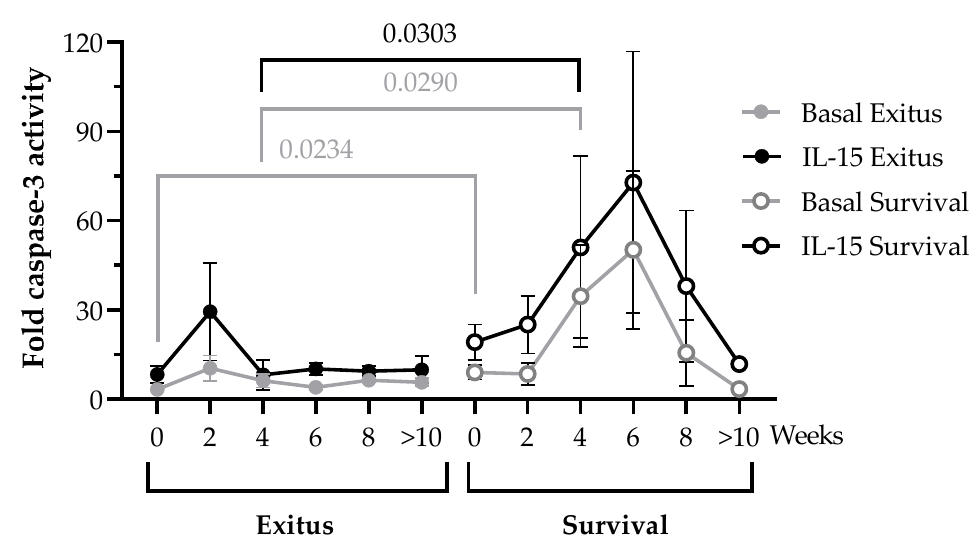
Figure 3. Direct cellular cytotoxicity of PBMCs isolated from hospitalized patients with critical COVID-19. Cytotoxic capacity of PBMCs from individuals of the Exitus (filled dots) and Survival (blank dots) groups measured by quantifying caspase-3 activity in a monolayer of Vero E6 cells infected with pseudotyped SARS-CoV-2 after co-culture (1:1) for 1 h in basal conditions (gray lines) or after treatment with IL-15 for 48 h (black lines). Each dot corresponds to the mean of data, and vertical lines represent SEM. Statistical significance between groups was calculated using Mann–Whitney U-test, and within groups, Wilcoxon U-test was used.